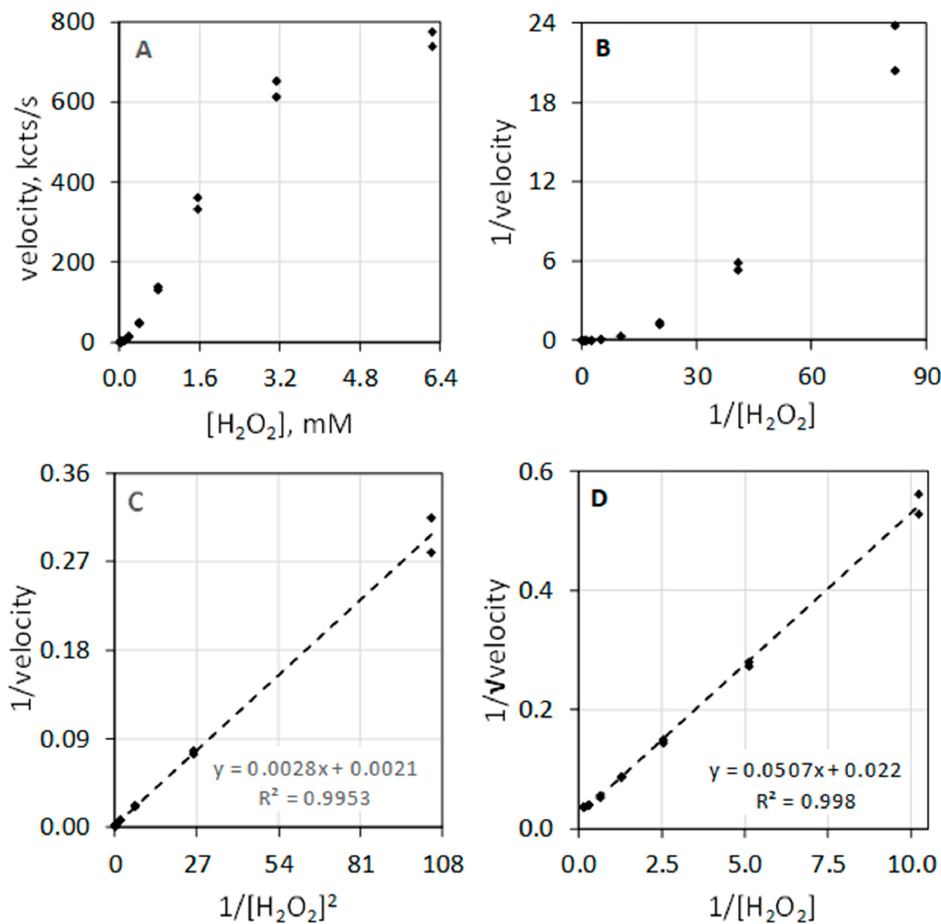
Figure 2. Luminescence velocity plotted against H 2 O 2 under conditions as described in Figure 1. ( A ) depicts the plot of velocity against H 2 O 2 to a concentration of 6.3 mM. ( B ) shows the standard double reciprocal (Lineweaver–Burk) plot of 1/velocity (1/(kcts/s)) against 1/[H 2 O 2 ] (1/mM). ( C ) shows that linearity is achieved when the reciprocal of velocity (1/(kcts/s)) is plotted against the 1/[H 2 O 2 ] 2 (1/(mM) 2 ). ( D ) shows that linearity is also achieved when the reciprocal of the square √ √ root of the velocity (1/ velocity) (1/ (kcts/s)) is plotted against 1/[H 2 O 2 ]